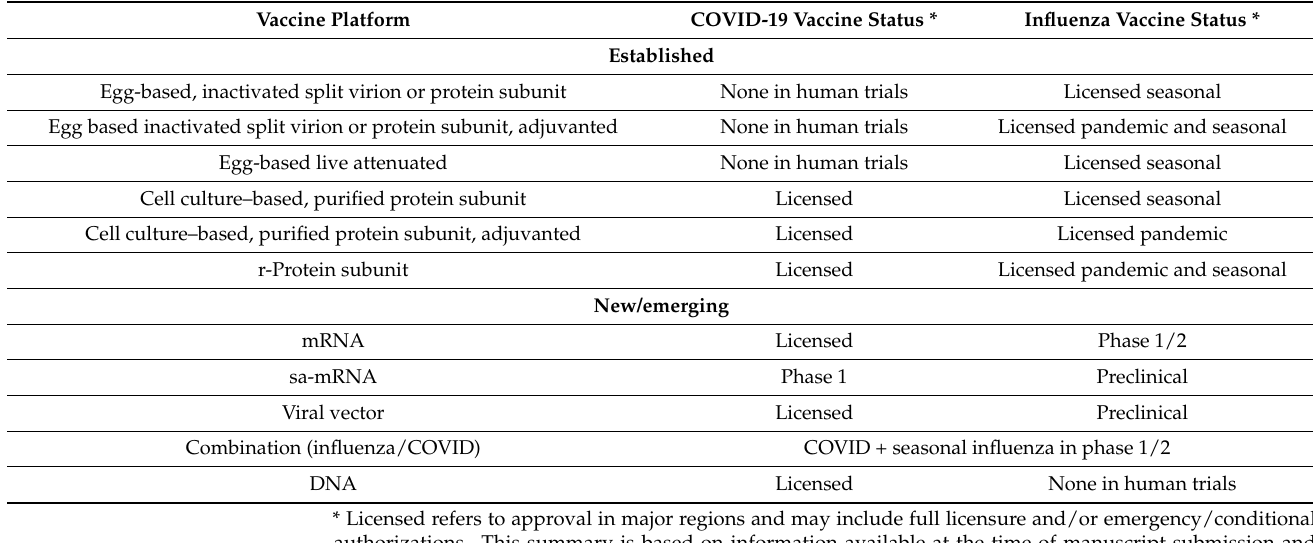
Table 1. Established, new, and emerging vaccine technologies